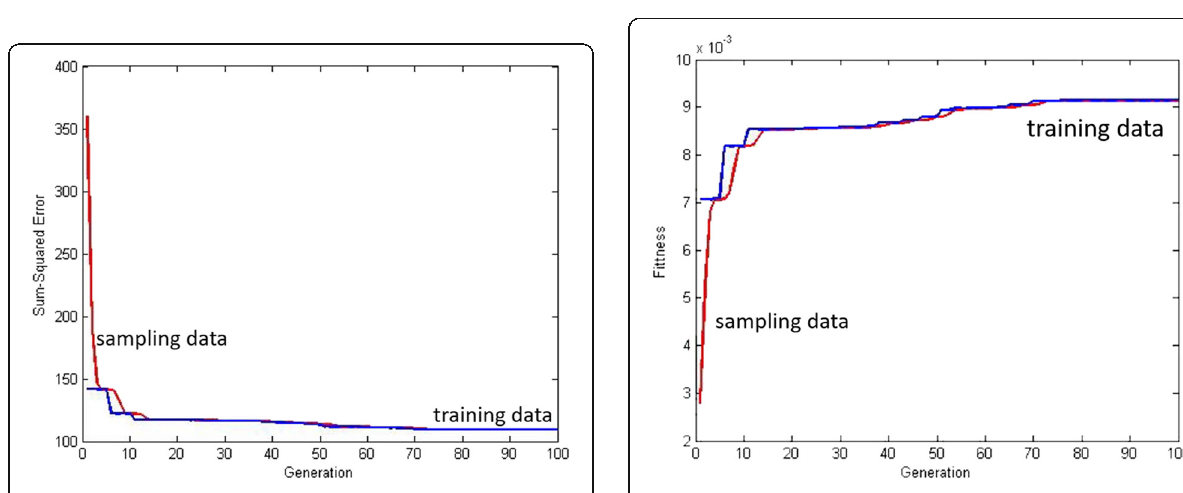
Fig. 12 The error sum of squares vs. generation Fig. 13 Generation vs.